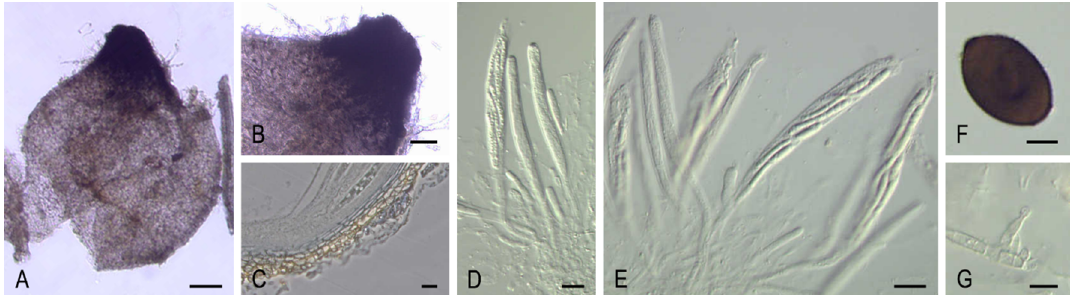
Figure 6 . Cladorrhinum coprophilum SMH 3792. ( A ) Ascoma. ( B ) Neck. ( D,E ) Asci. ( F ) Ascospore. ( G ) Phialidic conidiogenous cell and conidia. Cladorrhinum coprophilum SMH 3083. ( C ) Ascomatal wall. Scale bars: ( A ) = 100 µm; ( B ) = 50 µm; ( C – E ) = 20 µm; ( F , G ) = 5 µm. Because the reference strain of Arnium olerum formed a well-supported terminal lineage with Cladorrhinum foecundissimum (100% bs / 0.98 pp), the synonymy of A. olerum under C. foecundissimum is proposed here.